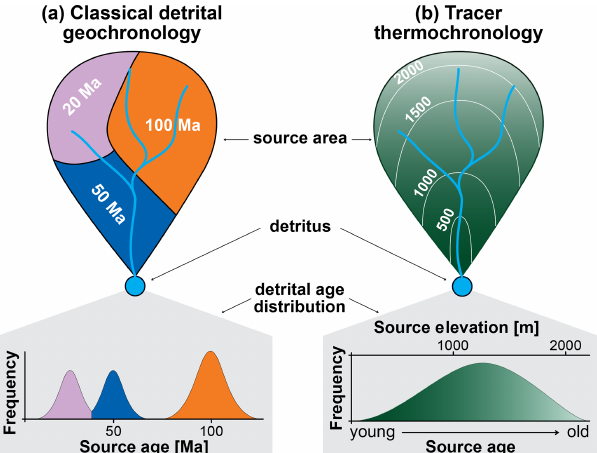
Figure 1. Sketch of the difference between classical detrital geochronology (a) and tracer thermochronology (b) . (a) Discrete age components are found in the detritus and refer to different up- stream geological units. (b) A continuous detrital age distribution informs the relative abundance of material sourced from different elevations based on a known age–elevation